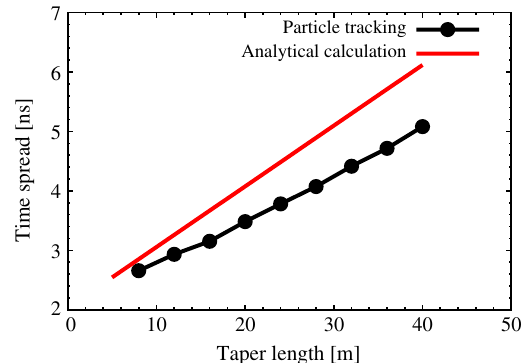
FIG. 9. The rms time spread of the muon beam at the end of decay channel as a function of the solenoid taper length. Simulations with our field number are shown with squares, the results of applying Eq. (3) to the distribution at the target are shown with a line.